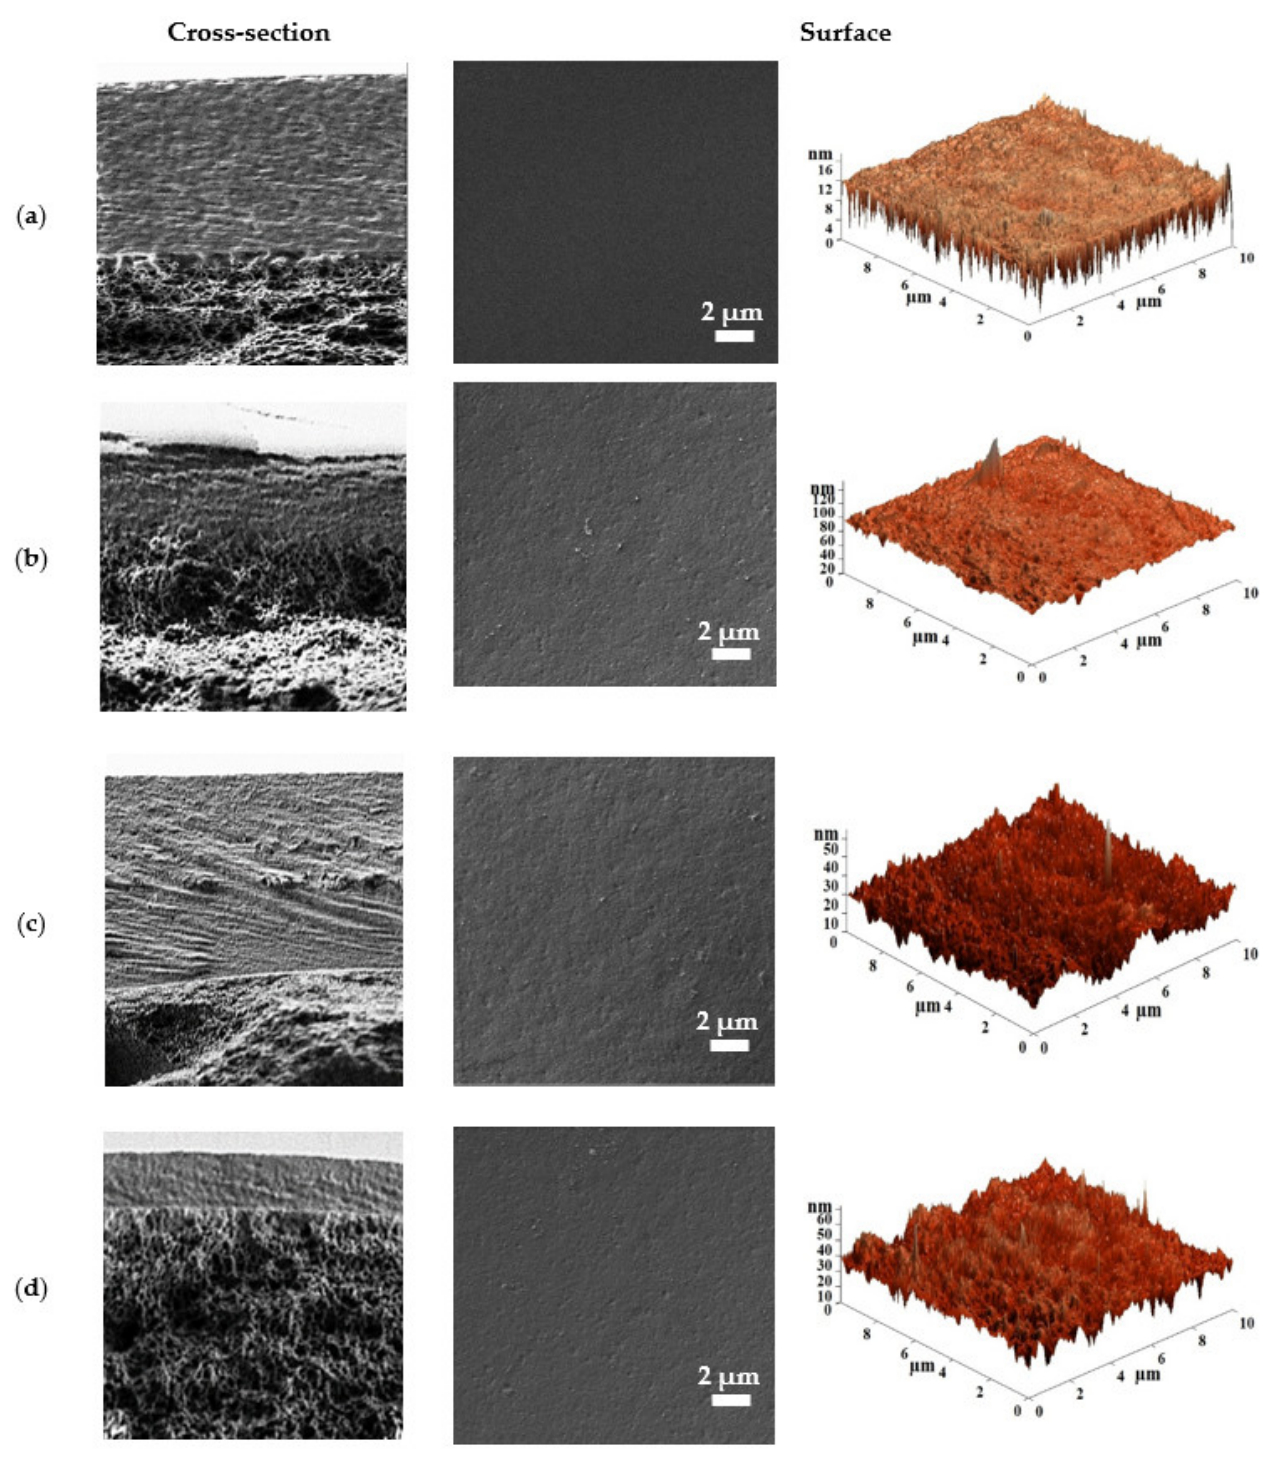
Figure 11. Cross-sectional and surface SEM micrographs and surface AFM images of ( a ) CMC/CA-15, ( b ) CMC + Zn(SEB) (15%)/CA-15, ( c ) CMC + Zn(BDC)Si (15%)/CA-15, and ( d ) CMC + Zn(BIM) (15%)/CA-15 membranes.